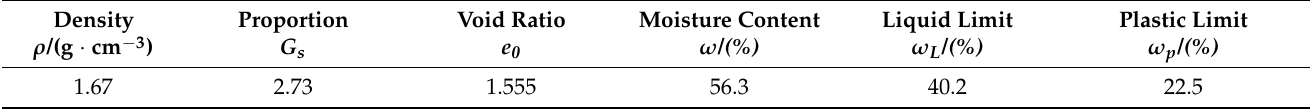
Table 2. Clay parameters.